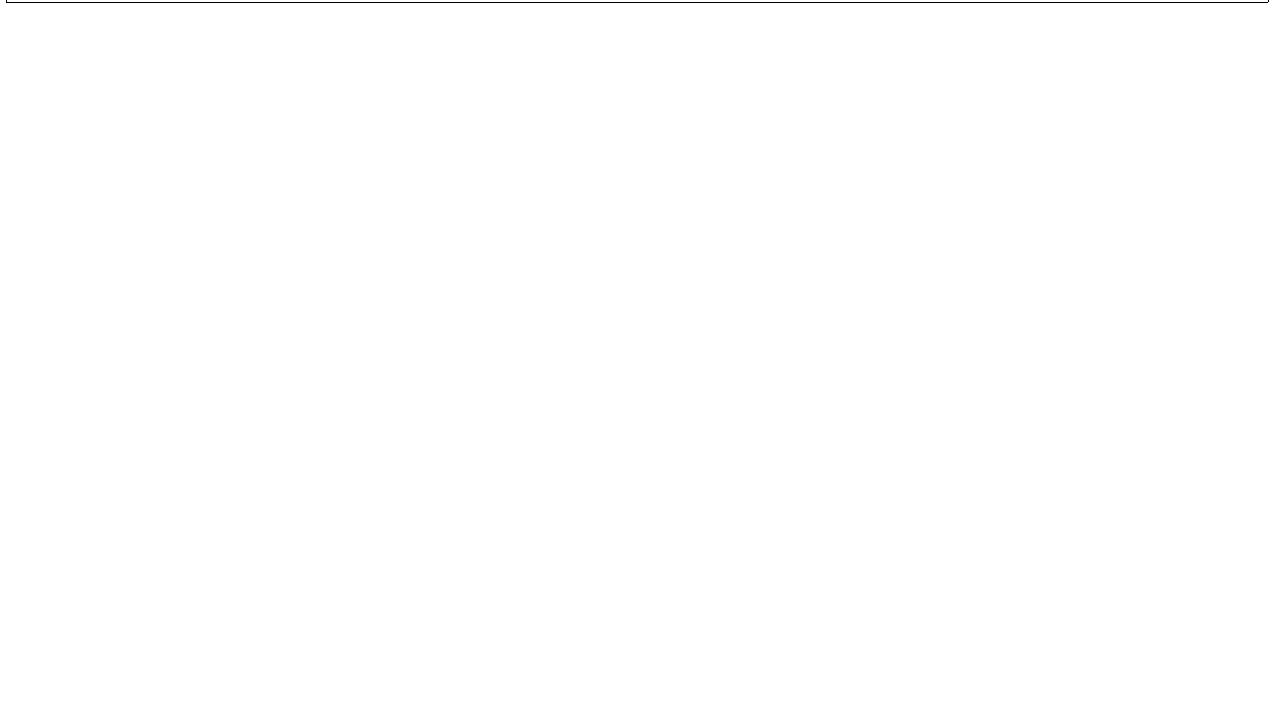
density of clustering, black dots represent highest density. Low (0.1 and 0.5% decisive data), mid (1% decisive data), and high (5 and 10% decisive